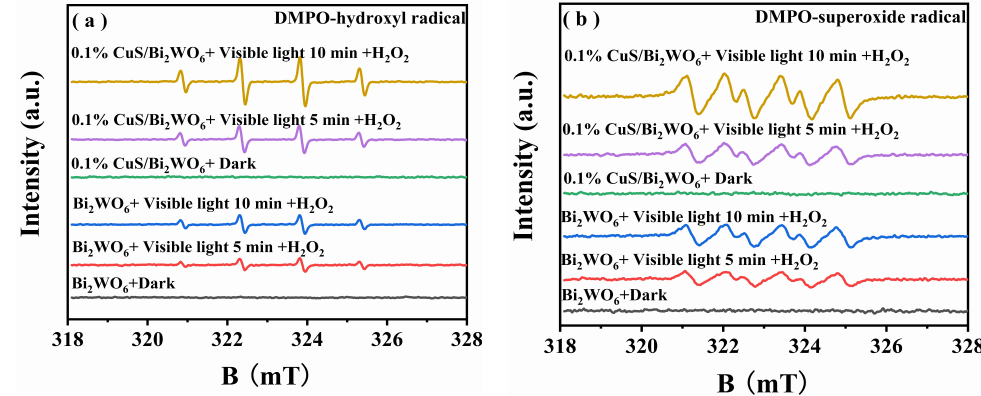
Figure 11. DMPO spin-trapping ESR spectra of Bi 2 WO 6 and 0.1% CuS / Bi 2 WO 6 heterostructure for ( a ) DMPO- · OH in aqueous dispersion and ( b ) DMPO- · O 2 − in methanol dispersion in the dark or under visible light irradiation and in the presence of H 2 O 2 , respectively.